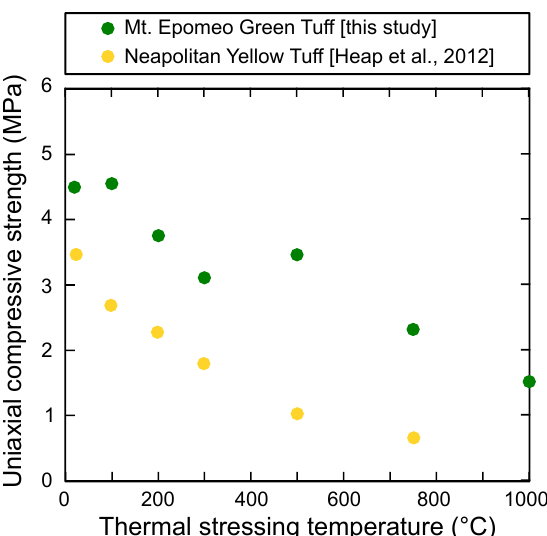
Figure 12: Uniaxial compressive strength (UCS) as a function of thermal stressing temperature for Mt. Epomeo Green Tu ff (MEGT) (data from this study; sym- bols represent the average of two experiments, see Ta- ble 2) and Neapolitan Yellow Tu ff (data from Heap et al.